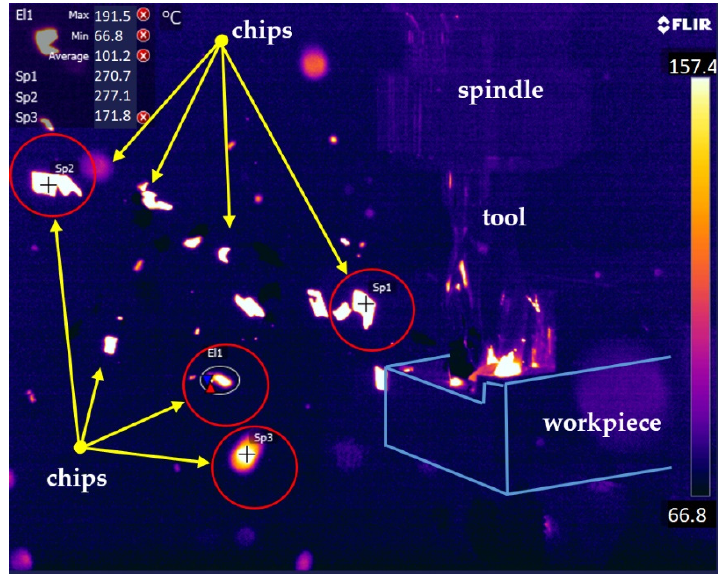
Figure 8. Exemplary thermal imaging of chips removed from the working space during machining.